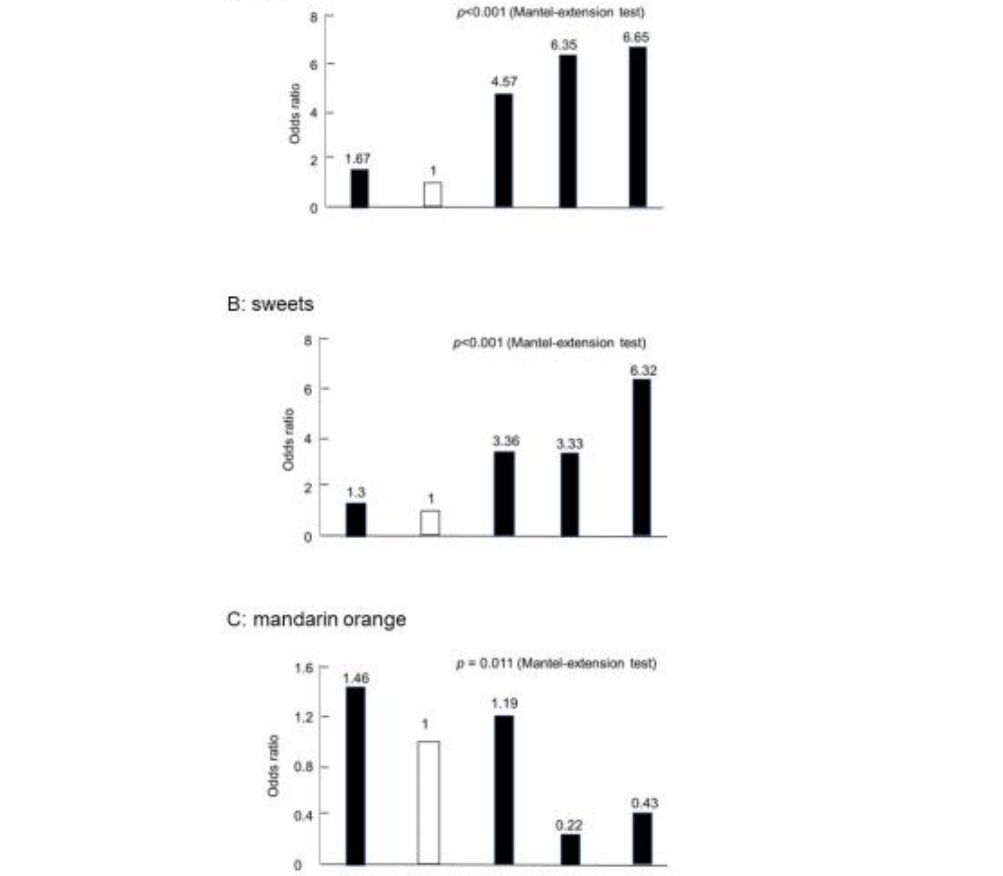
new cases of the respective diseases (r = 0.970) (Figure 5) indicates the presence of a com- Figure 3 Case-control study in Crohn ’ s disease in Japan (CD n = 104) Figure 3. Case-control study in Crohn’s disease in Japan (CD n = 104). mon environmental factor in both UC and CD [14]. 2.3.2. Dietary transition from a traditional diet to a westernized diet. It might be more appropriate to look at dietary transition as a whole to evaluate dietary factors in IBD. Ja- pan provides excellent conditions for analyses of dietary factors in IBD because the back- ground of the Japanese population is rather homogeneous genetically and culturally. In- creased incidence of IBD in association with dietary westernization was found in Japan (Figure 4) [14]. In addition, an extremely high correlation between the annual numbers of